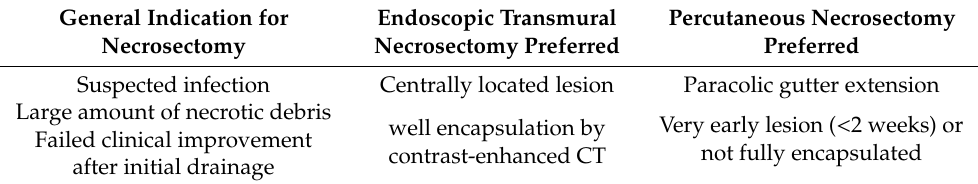
Table 1. Indication for necrosectomy